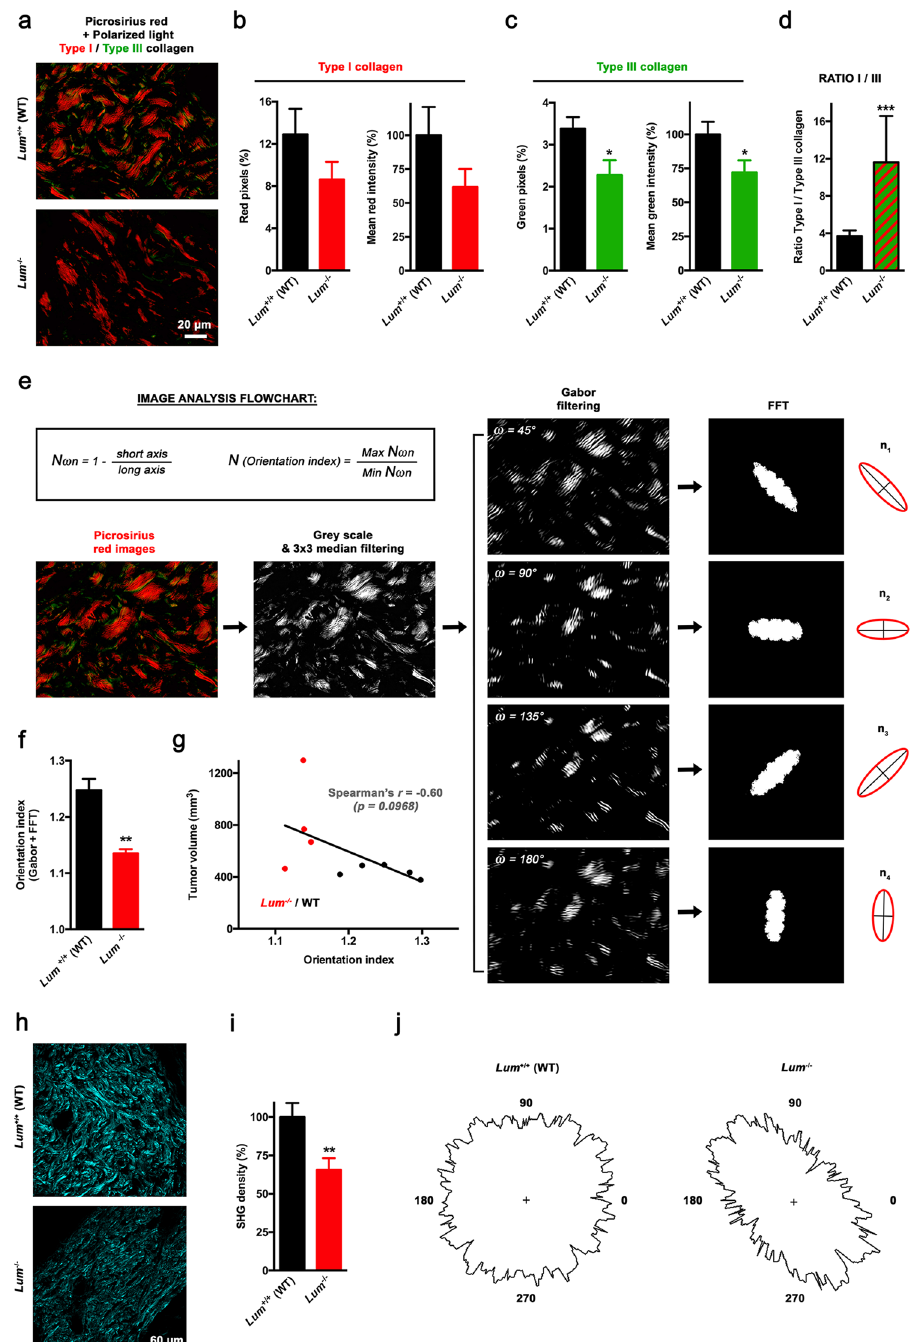
Figure 7. Investigation of the relationship between lumican and intratumoral collagen organization. ( a ) Representative microphotographs of s.c. allograft sections stained with picrosirius red and viewed under dark- field cross-polar optics (original magnification × 63). Birefringence of collagen fibers allows distinction between type I (red) and type III (green) collagen. ( b , c ) Quantification of the relative distribution of red ( b , left panel ) and green ( c , left panel ) pixels as well as the corresponding intensities ( b and c , right panels ), expressed as a percentage of mean pixel intensity in the Lum + / + (WT) group (mean ± SEM, t test, * p < 0.05). ( d ) Quantification of type I/type III ratio based on red and green pixel calculations, respectively. Individual ratios were calculated from 3 different fields per animal, and then averaged (mean ± SEM, t test, *** p < 0.001). ( e – g ) Quantification of tumor ECM collagen organization from spectra derived from Gabor filtering and FFT. ( e ) Flowchart depicting the different stages of image analysis. From grey scale-converted picrosirius- stained images, a 3 × 3 median filter is applied before Gabor filtering and then FFT. After determining the elliptical shape of the scatter pattern (see red ellipses on right panel ), measurements of the elliptical axes ( black lines ) generated from ω angle values n 1 to n 4 were performed so as to produce a collagen